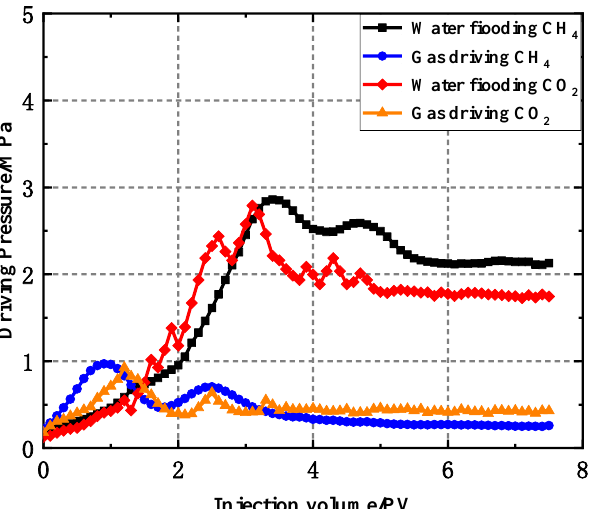
Figure 17. Experimental results of plugging with different gases when injecting glue first and then the gas.